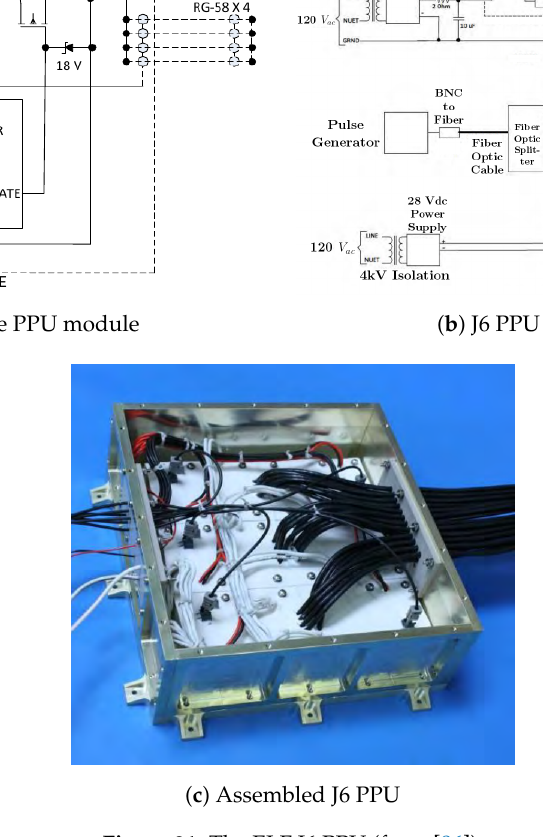
Figure 21. The ELF J6 PPU (from